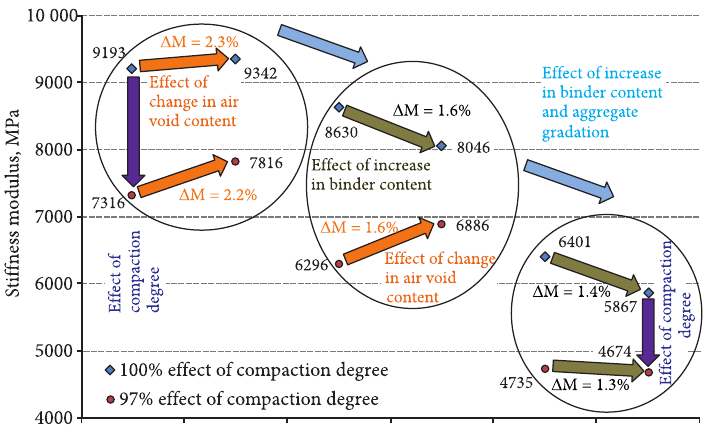
Fig. 5. Comparison of stiffness modulus of AC 16 mixtures depending on the degree of compaction (ΔM is the difference between air void content of mixture with optimal binder content and air void content of mixture with binder content reduced by